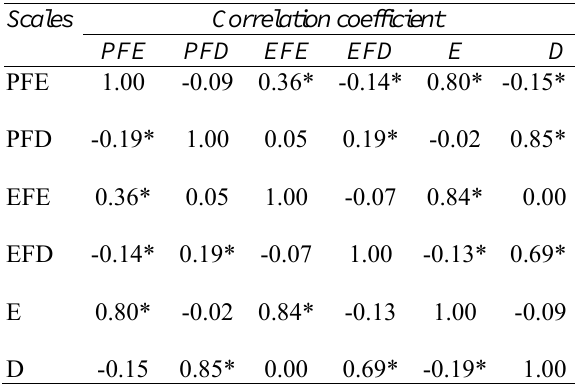
Table 3: Pearson Correlation of CSI-SF Scales and Subscales Scales